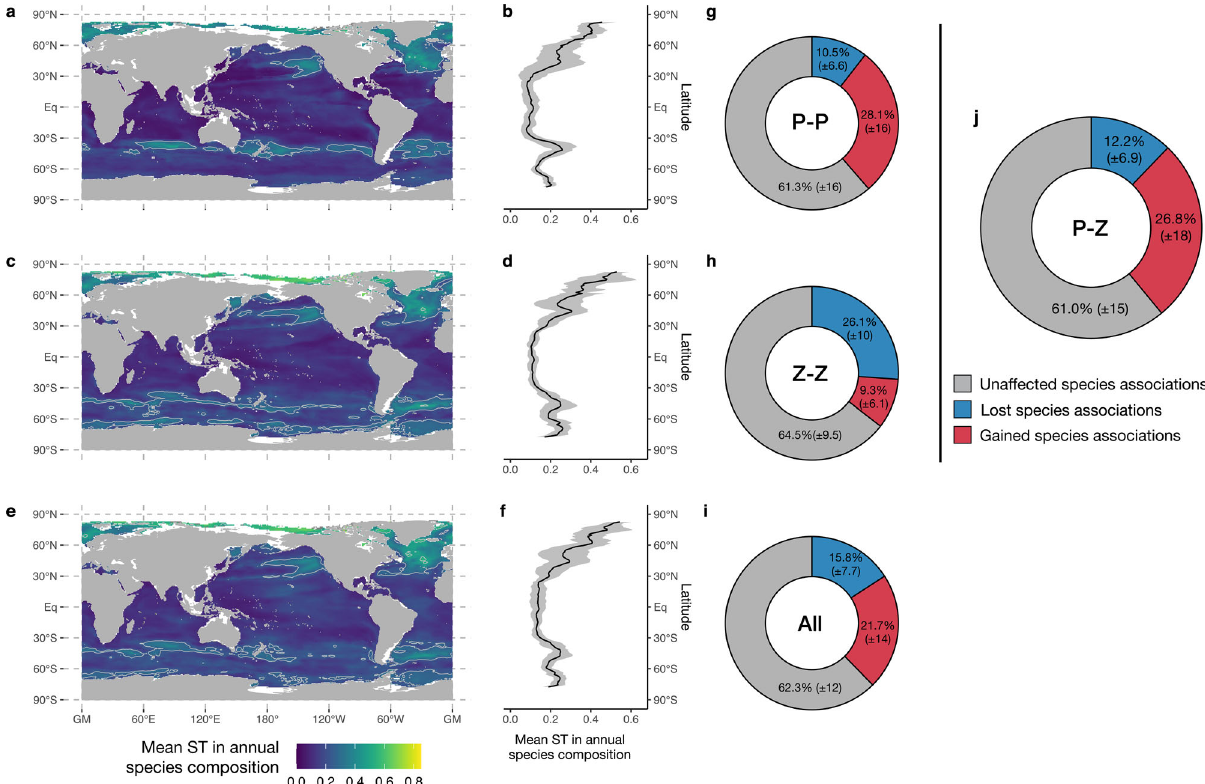
Fig. 3 Global patterns of species turnover (ST, true turnover component of Jaccard ’ s dissimilarity index) and changes in species associations between 2012 – 2031 and 2081 – 2100. a Map of annual mean ST of phytoplankton species and its zonal average ( b ). c and d same as a and b but for zooplankton. e and f same as a and b but for all plankton. g Changes in phytoplankton species associations with the color indicating the percentage of species associations that are lost (blue), gained (red), or that remain constant (gray). h same as g but for zooplankton. i same as g but for all plankton. j as g but for the associations between phyto- and zooplankton species. The median (±IQR) relative contribution (%) of the three types of species associations to the total number of species associations identi fi ed as signi fi cant in the contemporary and future ocean are given in g , h , i , and j . The pale contour lines in a , c , and d indicate the isopleths of 25% mean ST. The gray contours in b , d , and f illustrate the standard deviation (std) associated with the zonal average displayed by the bold line. Total sample size is N = 35,023 grid